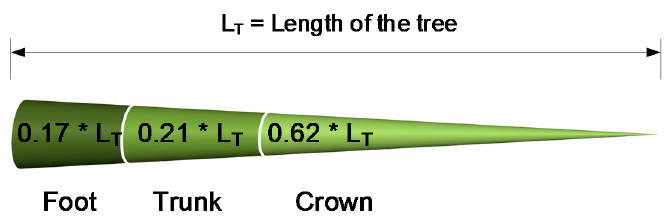
Figure 4. Division of the trees into three sections of equal weight.